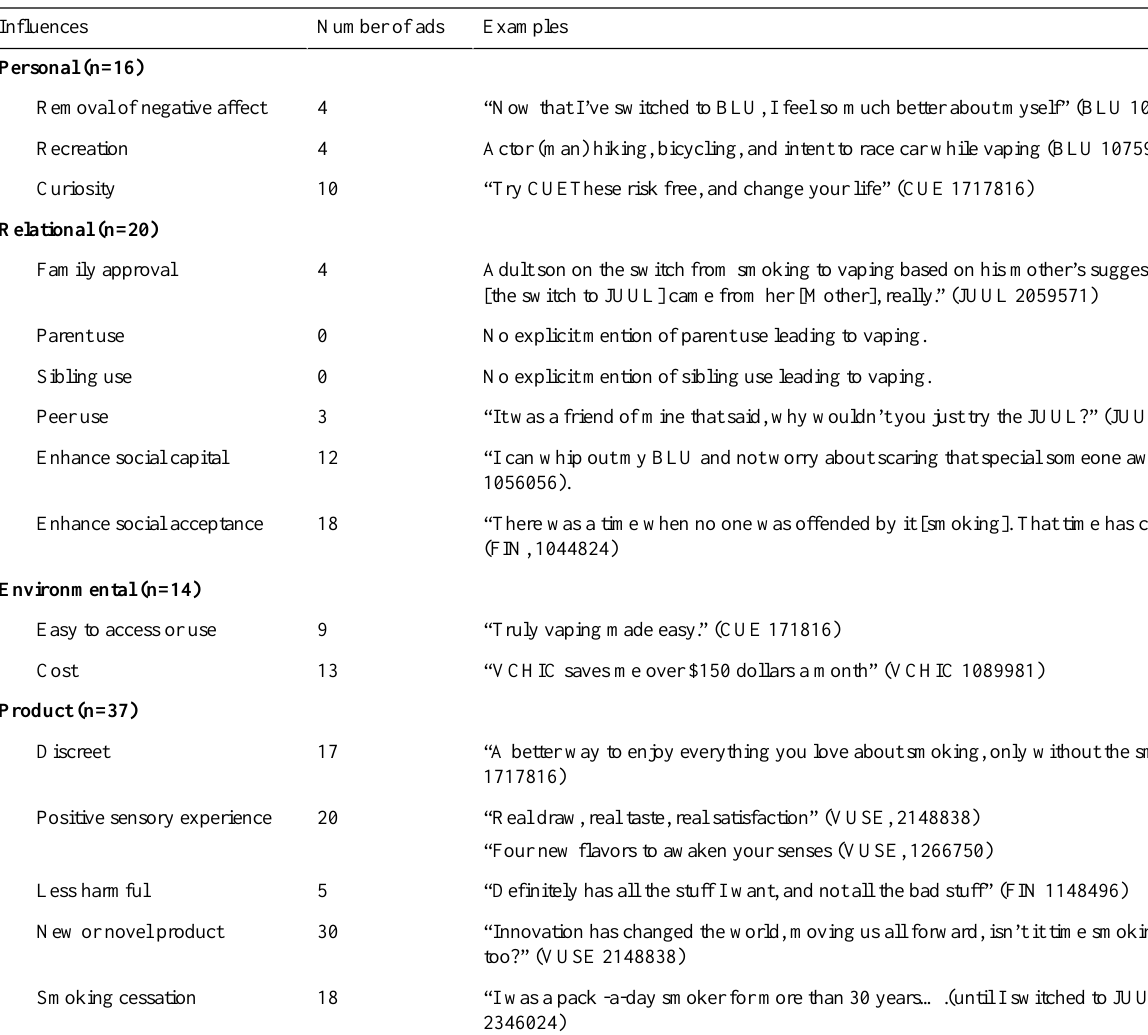
Table 2. Content analysis of vaping